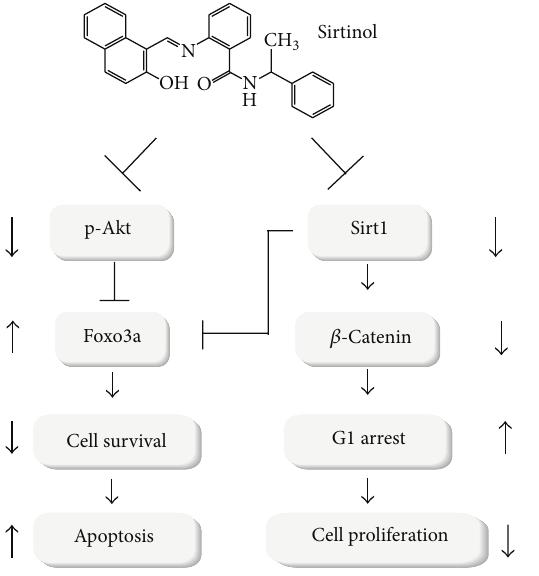
Figure 6: Possible model of sirtinol-induced antiproliferation and apoptosis in lung cancer cells. Sirtinol downregulates the activation of prosurvival Akt serine/threonine kinase and the protein level of 𝛽 -catenin, a proliferation-associated transcription factor, insulting in the cell cycle G 1 -phase accumulation and the growth